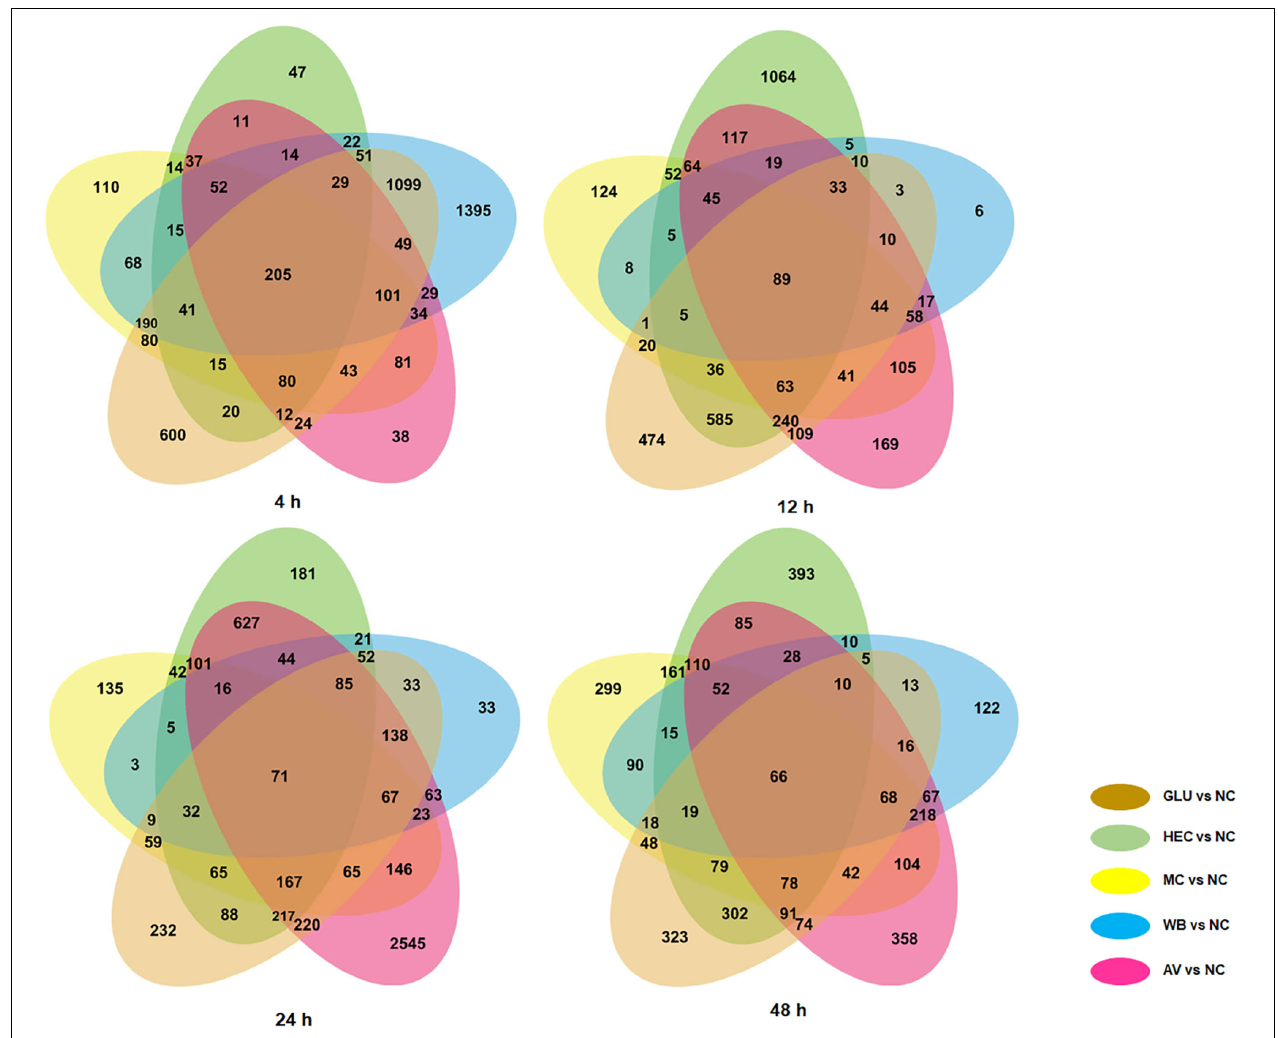
FIGURE 3 | Venn diagram indicating numbers of unique and shared DEGs in transcriptomes from P. oxalicum strain (cid:49) PoxKu70 in the presence of different carbon sources (AV, MC, HEC, WB, and GLU) compared with NC. DEGs were selected using the thresholds of p -value ≤ 0.05 and | log2 fold change| ≥ 1. DEGs, differentially expressed genes; AV, Avicel; MC, methyl cellulose; HEC, 2-hydroxyethyl cellulose; GLU, glucose; NC, no carbon